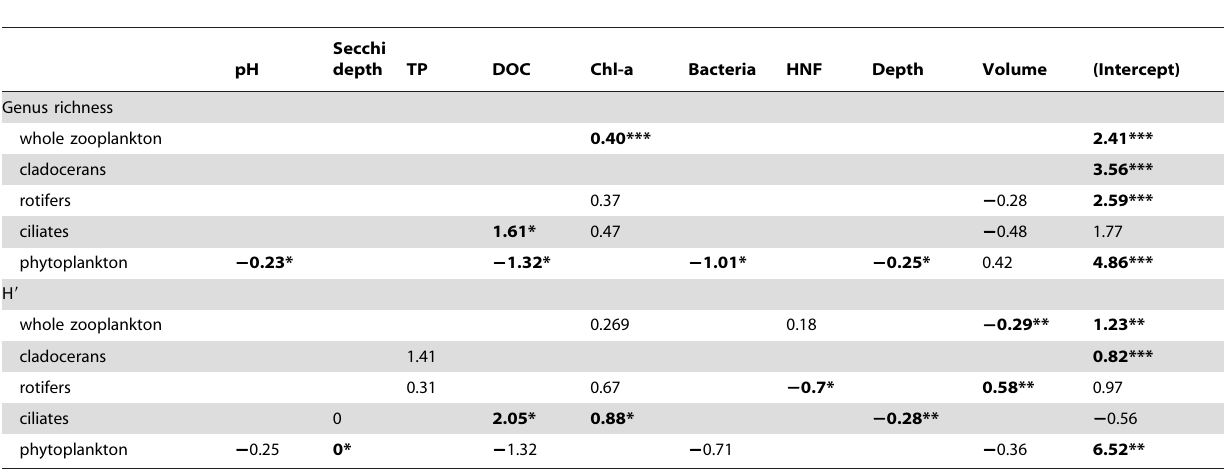
Table 1. The best generalized linear model (GLM) results for genus richness and species diversity index ( H 9 ) of whole zooplankton, and 4 plankton taxonomic